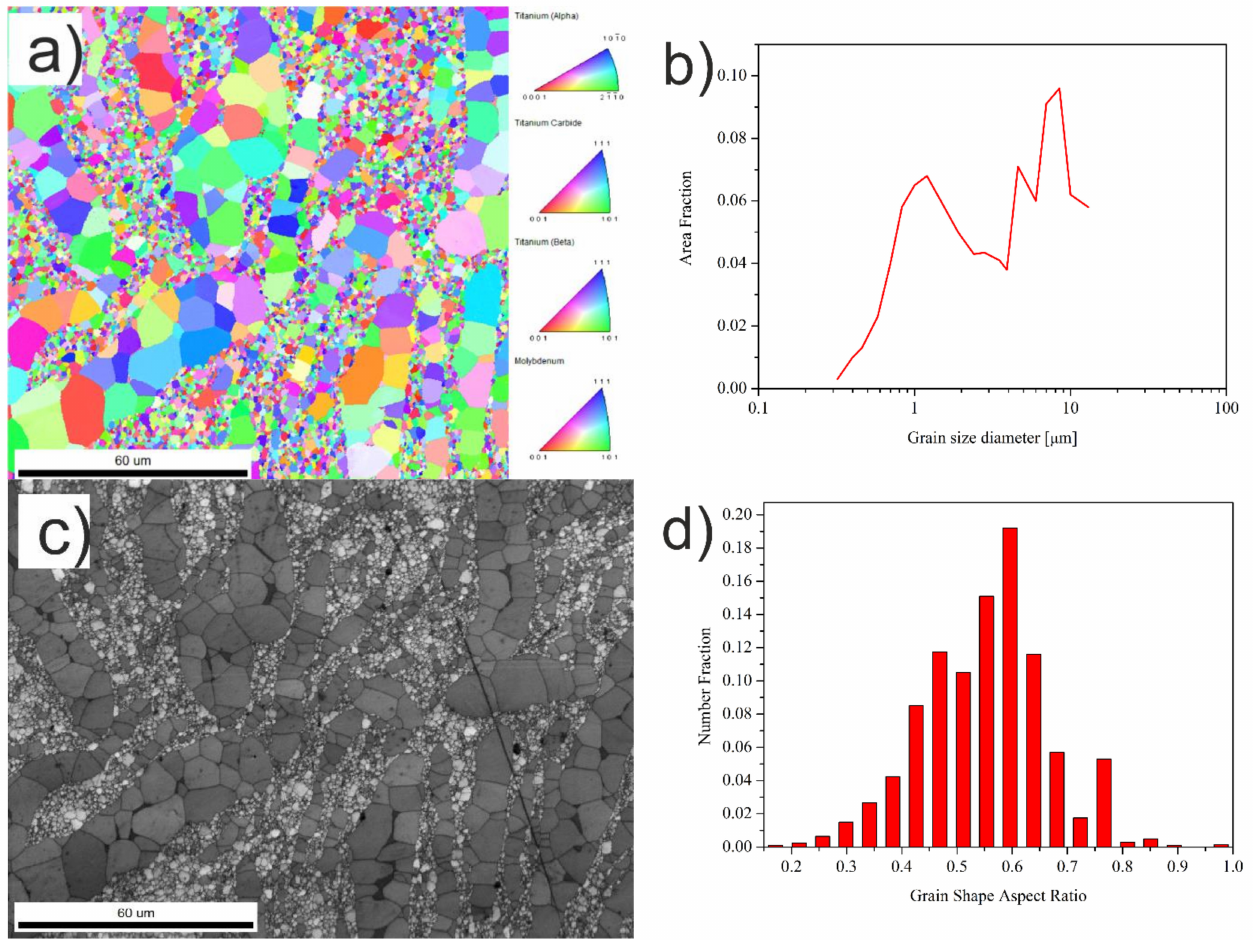
Figure 2. ( a ) EBSD micrograph; ( b ) grain size distribution; ( c ) SEM micrograph; ( d ) grain shape aspect ratio of the Ti + 20 wt %TiMoC